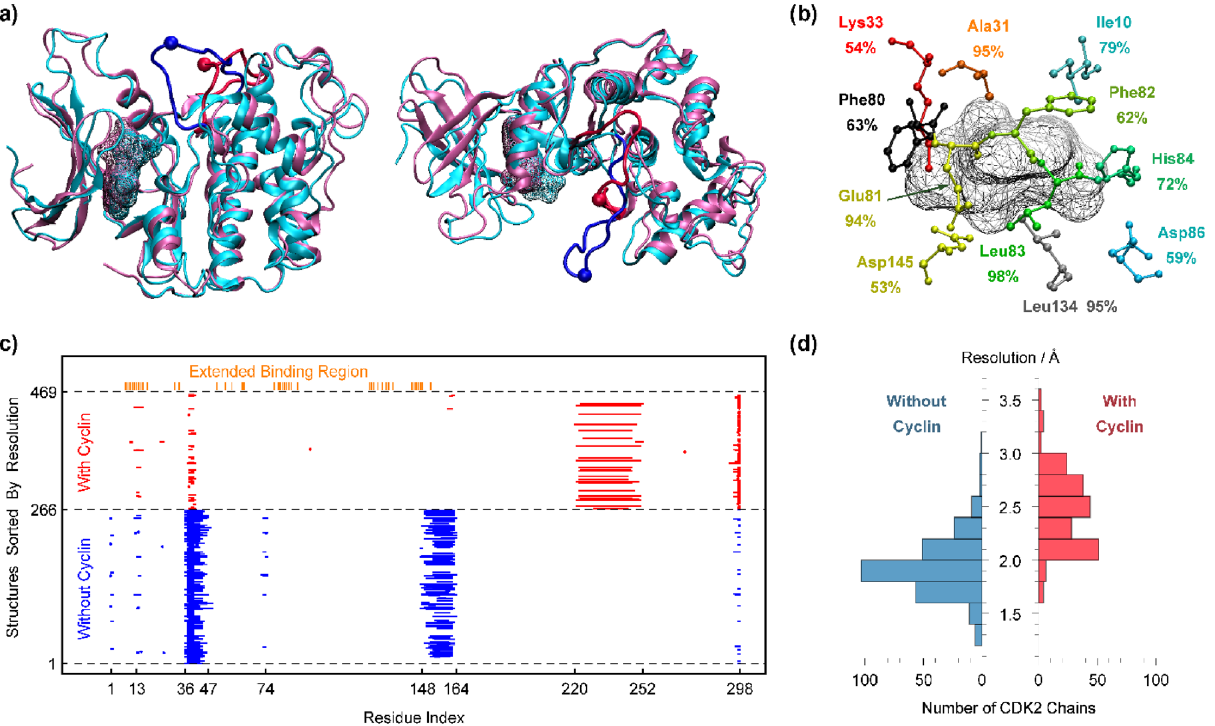
Figure 1. ( a ) Side and top views of two representative CDK2 structures (1FQ1B in cyan and 1JSTA in pink). ATP molecules in binding sites are in wireframe. The activation loop is colored in blue (1FQ1B) or red (1JSTA) with a bead in position of Thr160 (1FQ1B) or its phosphorylated form Tpo160 (1JSTA). ( b ) Extended binding region around ATP molecule (1JSTA). Only residues with more than 50% ligand contact among 315 structures were depicted. ( c ) Pattern of missing residues in initial receptor ensemble of CDK2 chains and position of residues in extended binding region along sequence. ( d ) Resolution of X-ray CDK2 structures complexed with or without